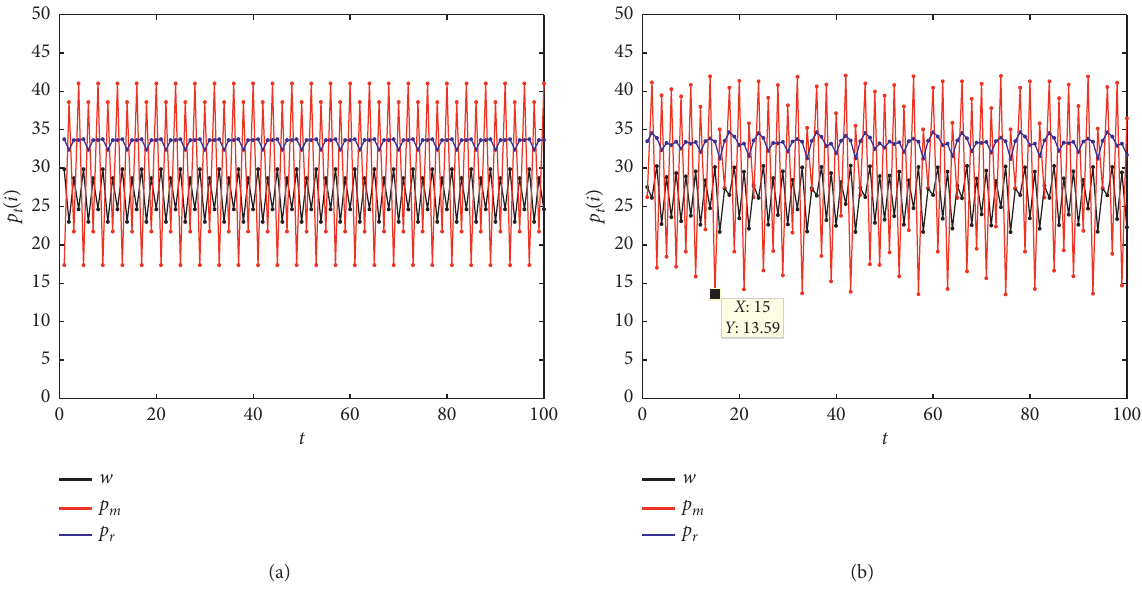
Figure 7: Wave plot of prices with the change of time. (a) α